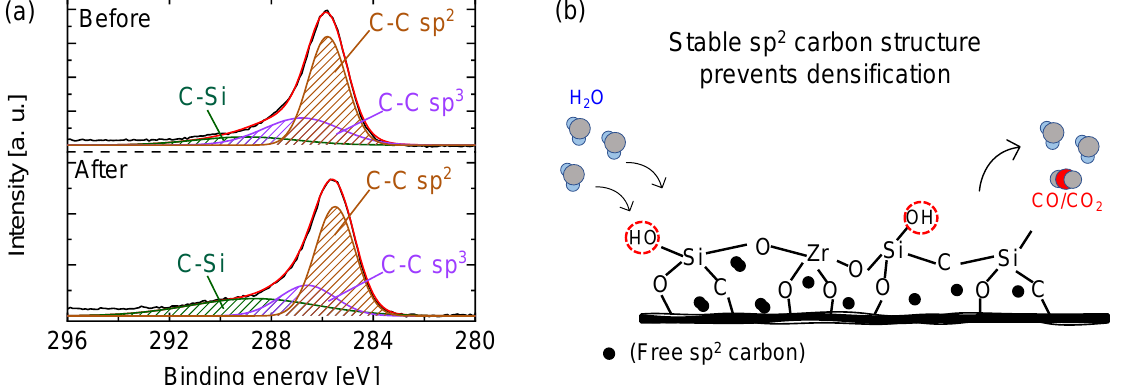
Figure 25. ( a ) C 1s X-ray photoelectron spectroscopy of carbon-SiO 2 -ZrO 2 films prepared at 750 °C from 200 °C-cured SiO 2 -ZrO 2 -polybenzoxazine resin before and after steam treatment at 500 °C, 90 kPa steam partial pressure. ( b ) Schematic illustration of the microstructural stability of carbon-SiO 2 -ZrO 2 membranes fabricated upon exposure to steam. Adapted from [111].